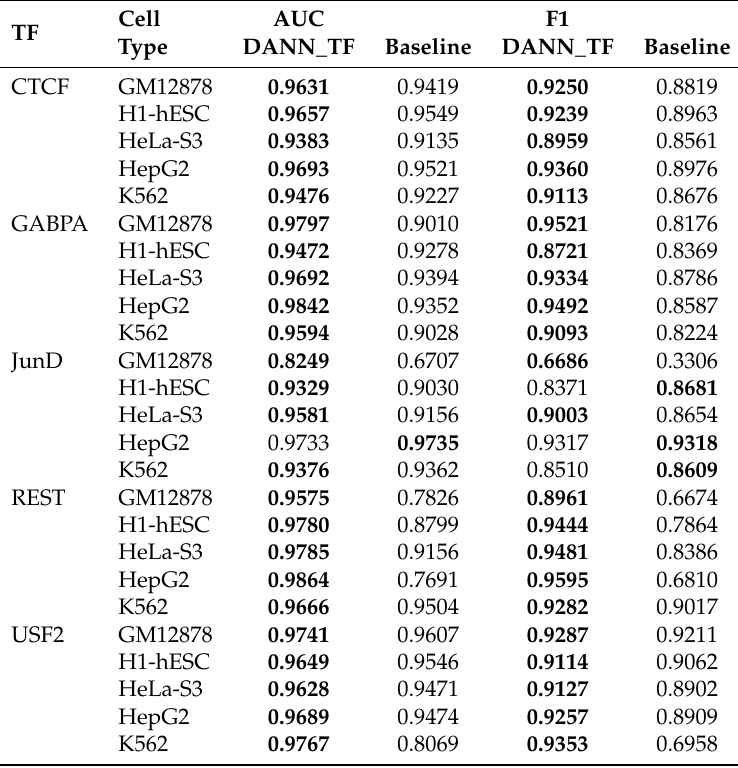
Table 1. Performance of DANN_TF for cross-cell-type prediction and that of the baseline method for supervised prediction. (The best performers are marked by